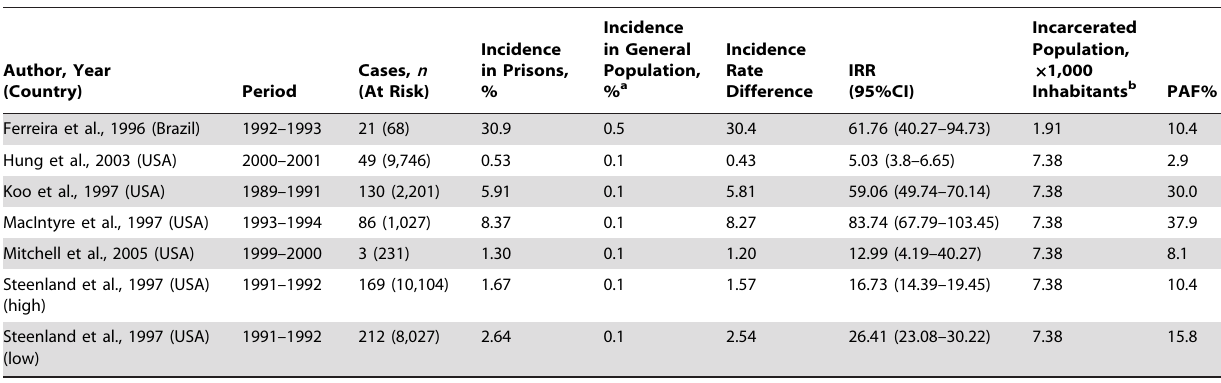
Table 1. Studies reporting LTBI incidence in